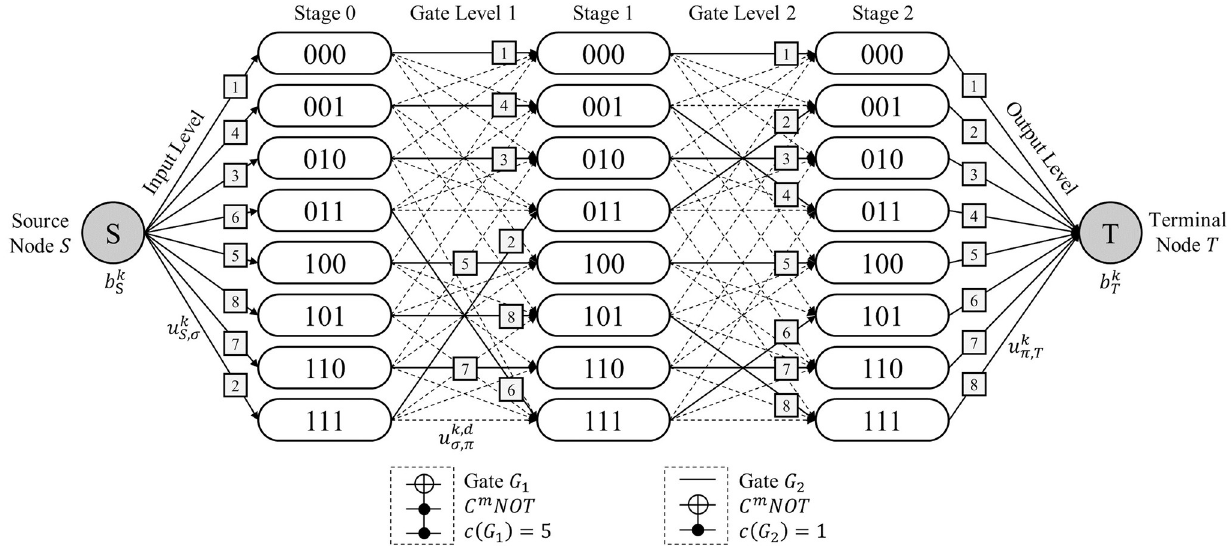
Fig 8. Network representation of MCT circuit for function F 1 .